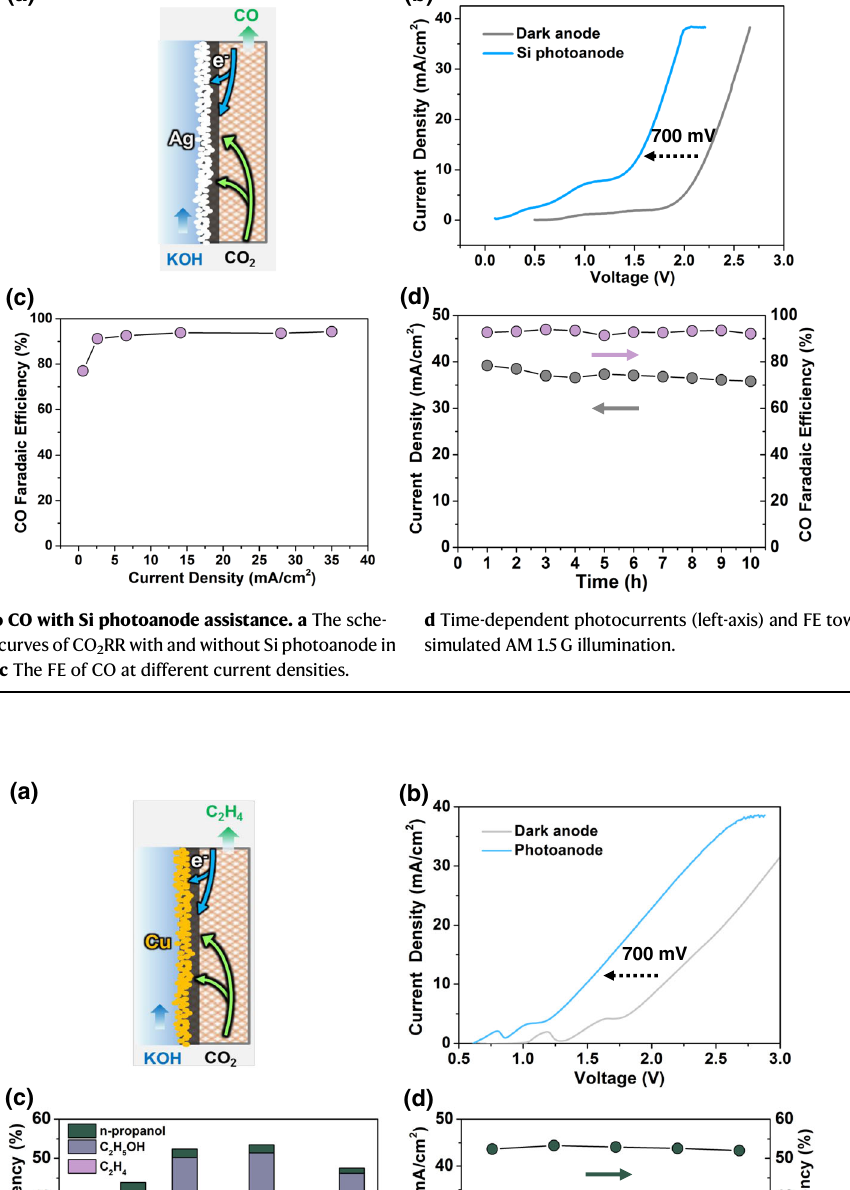
d Time-dependent photocurrents (left-axis) and FE toward C 2+ (right-axis) under simulated AM 1.5G illumination.